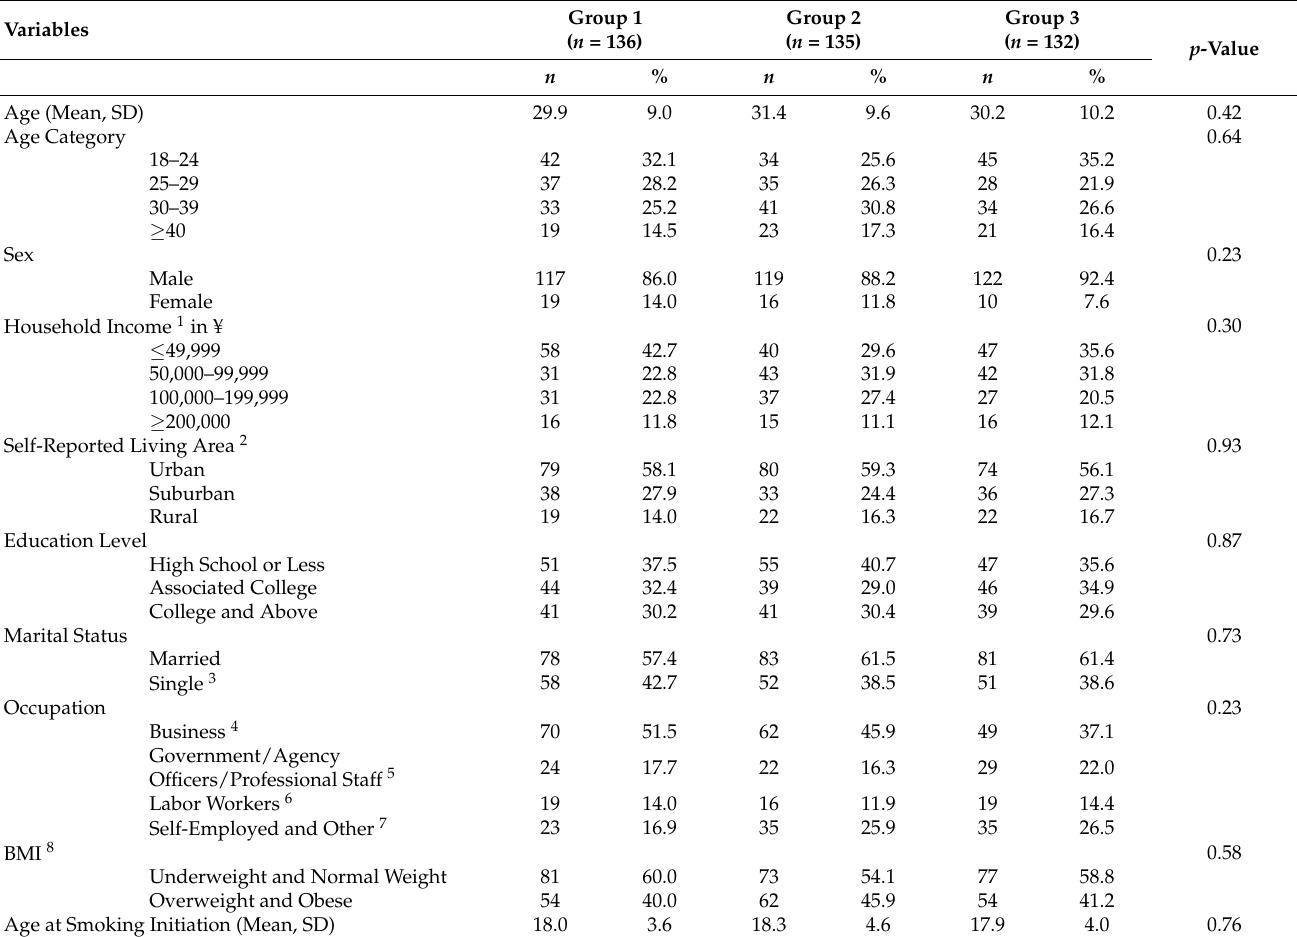
Table 1. Demographic information at